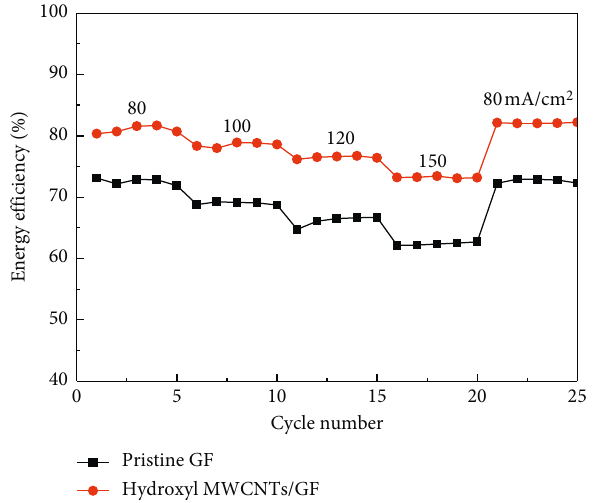
Figure 9: Variation of the EE of pristine GF and hydroxyl MWCNTs/GF-based single cells operating at the current density range of 80mA/cm 2 to 150mA/cm 2